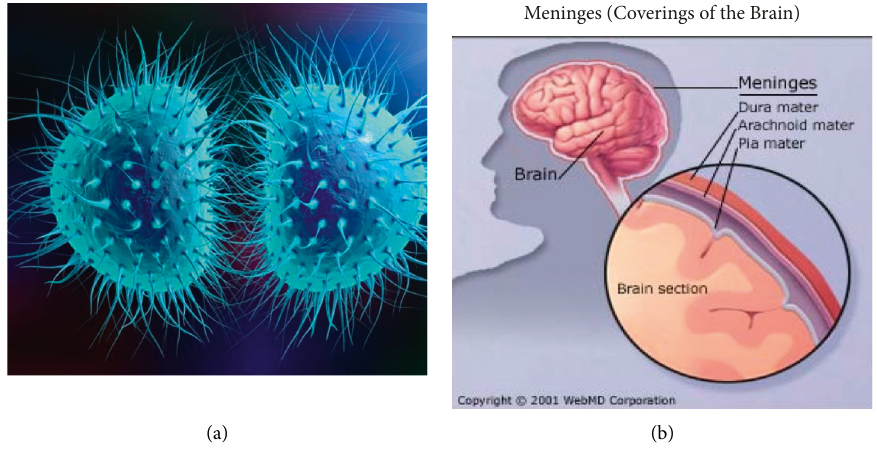
Figure 2: (a) Bacterial meningitis. (b) Anatomy of